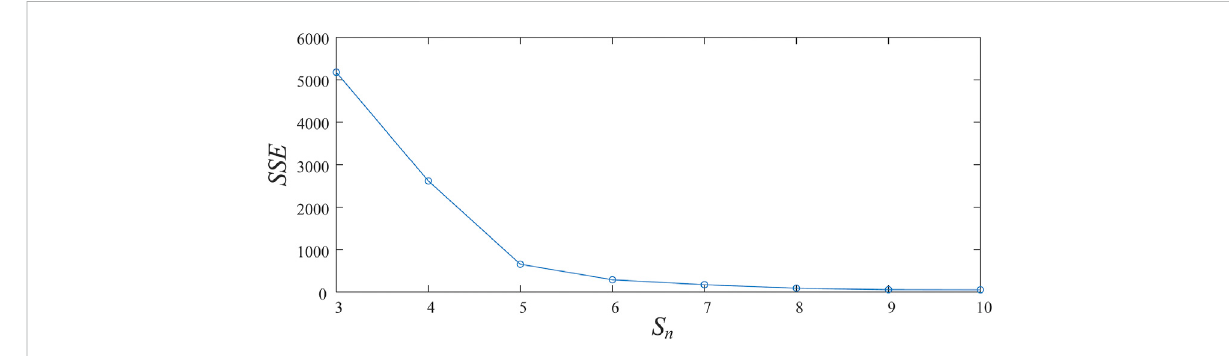
FIGURE 6 Distribution chart of SSE and S n.